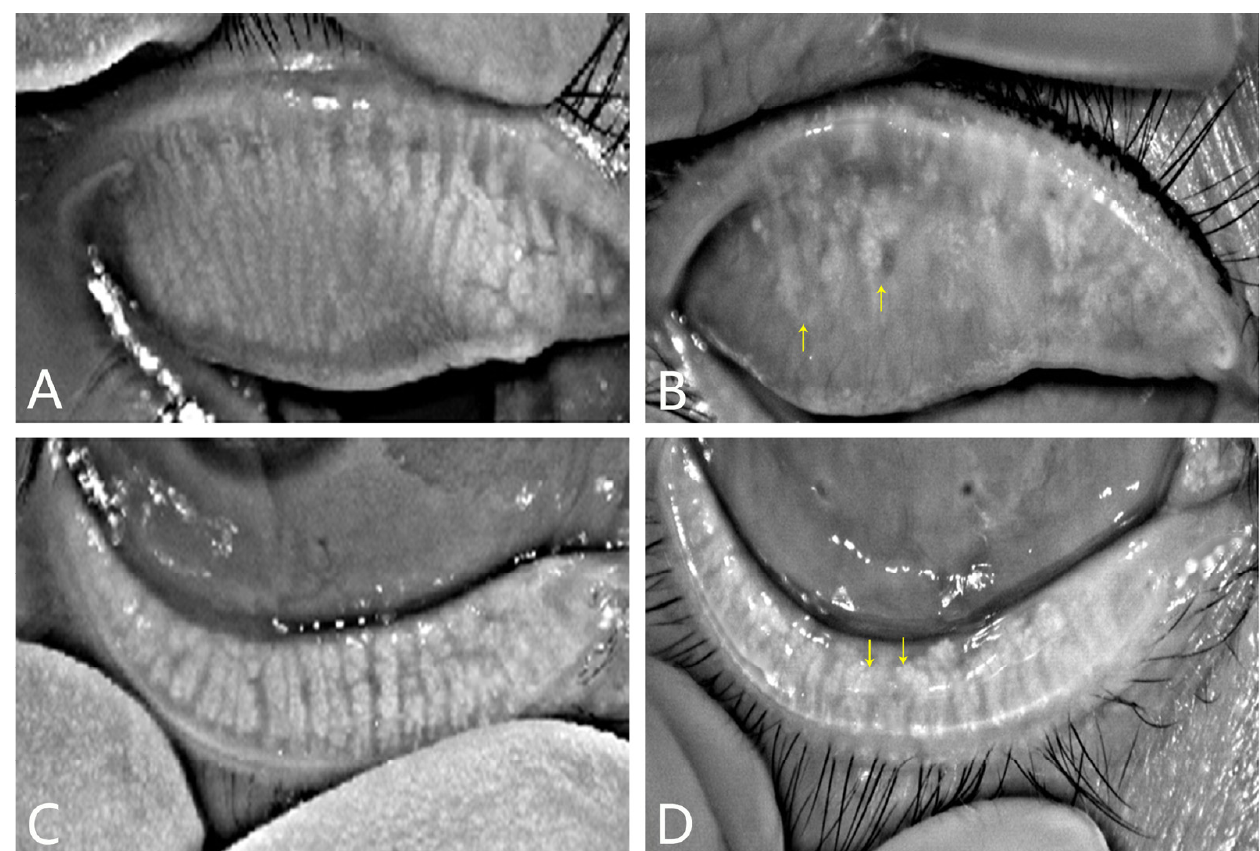
Figure 2. Representative images using noninvasive infrared meibography. Normal MGs of a young man show columnar and relatively straight glands, with those in the upper eyelid ( A ) being slenderer and more elongated than those in the lower eyelid ( C ). MGD individual with severe MG atrophy of the upper eyelid (( B ), yellow arrow) and mild MG atrophy in the lower eyelid (( D ), yellow arrow).